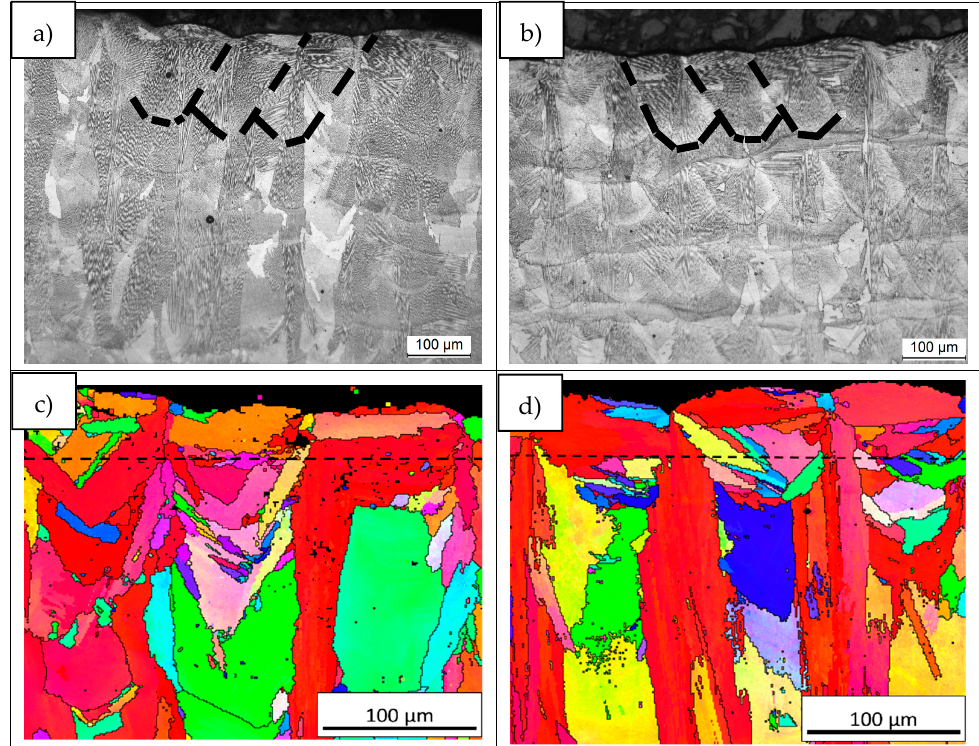
Figure 16. ( a ) LPW melt pools, ( b ) A&D melt pools, ( c ) IPF figure of LPW sample last layer and ( d ) IPF figure of A&D sample last layer.